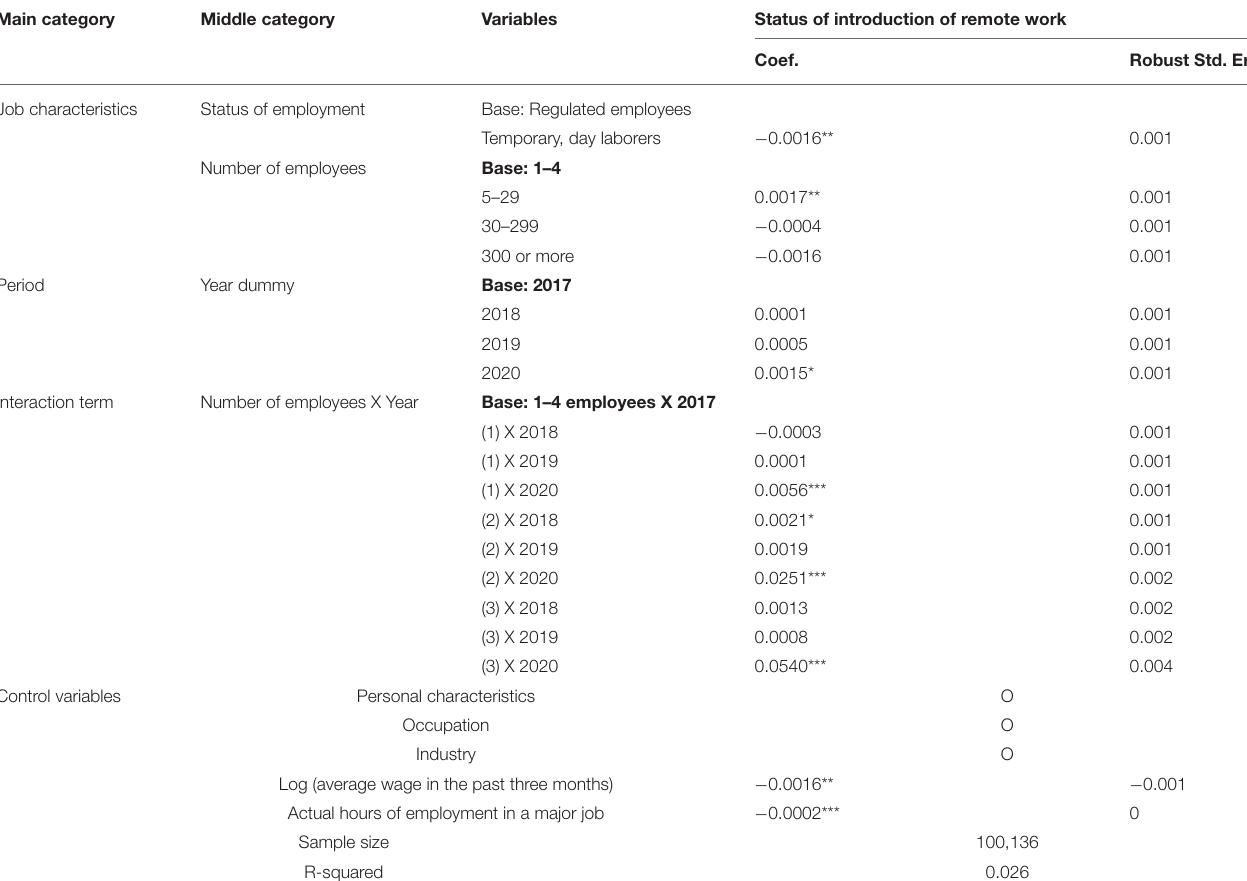
TABLE 4 | Interaction term analysis using the number of employees in a firm and year